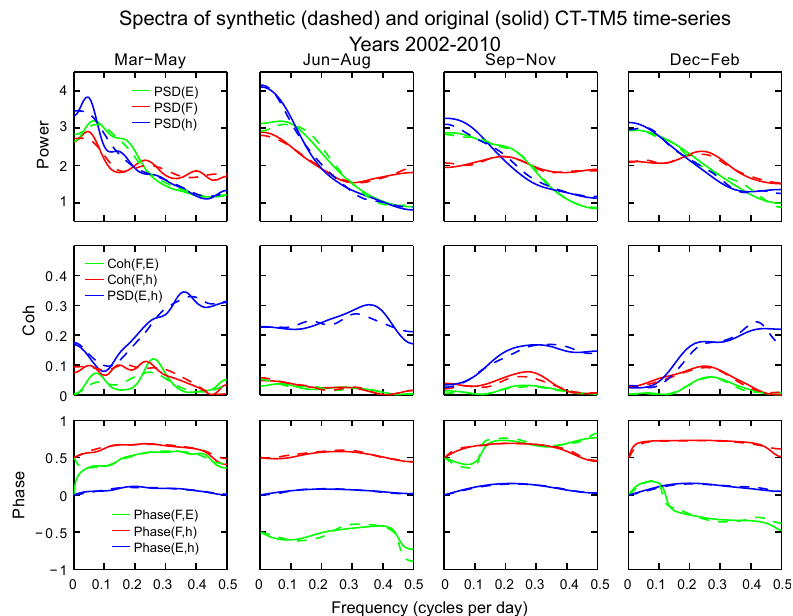
Fig. 1. Top row: power spectral density estimates for entrainment ( E , green lines), surface and horizontal CO 2 flux ( F , red lines), and boundary layer height ( h , blue lines) for original CT-TM5 time series (solid) and synthetic CT-TM5 time series (dashed) for each season, normalized in order to have equal area under each curve (equal standard deviation). Middle row: coherence spectra corresponding to the cross-spectral densities CSD F,E (green), CSD F,h (red), and CSD E,h (blue). Bottom row: phase spectra corresponding to the cross-spectral densities CSD F,E (green), CSD F,h (red), and CSD E,h